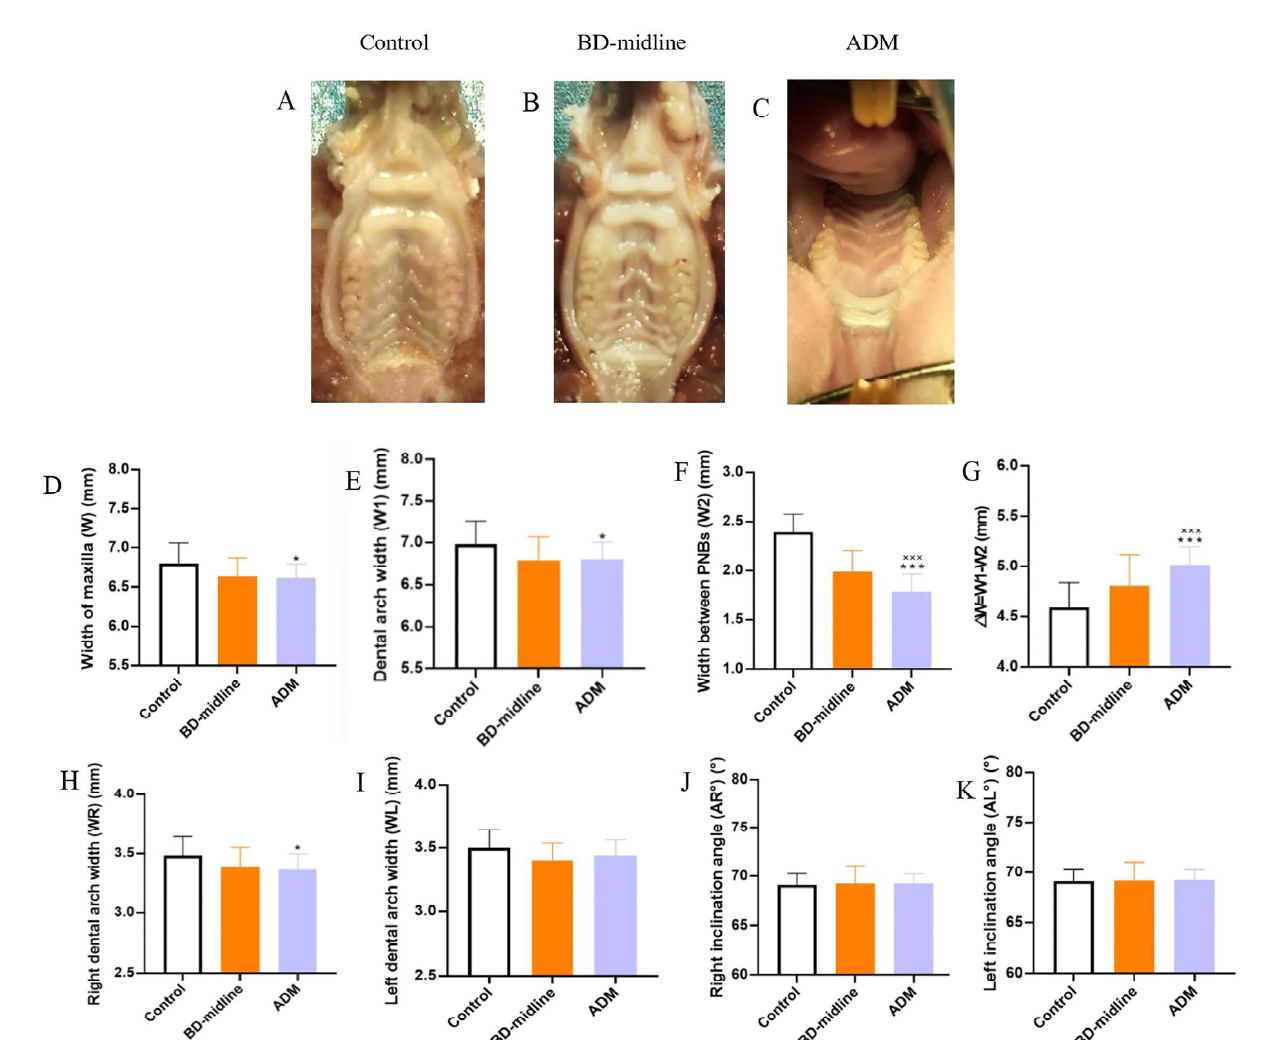
Figure 4. Inhibitions of the maxillofacial growth still happened after covering the bone denudation by ADM. Parameters demonstrated the inhibitions of the maxillofacial growth still happened after covering the bone denudation by ADM. One-way ANOVA was used to evaluate the statistical significance (* p < 0.05, *** p < 0.001). *: compared with the control group; × : compared with the BD-midline group; ( A – C ) The palatal rugae and scar on the palates at nine weeks among three experimental groups. ( D – K ) Parameters demonstrated the inhibitions of the maxillofacial growth among the control group, BD-midline, and ADM group. During the recovery process in the ADM groups, the histological analysis has shown that mild infiltration of local inflammatory cells happened on the fourth day after the material implantation. ADM degradation following granulation tissue can be found on the seventh day. The horizontal collagenous fibers are formed until the twenty-eighth day postoperatively (Figure